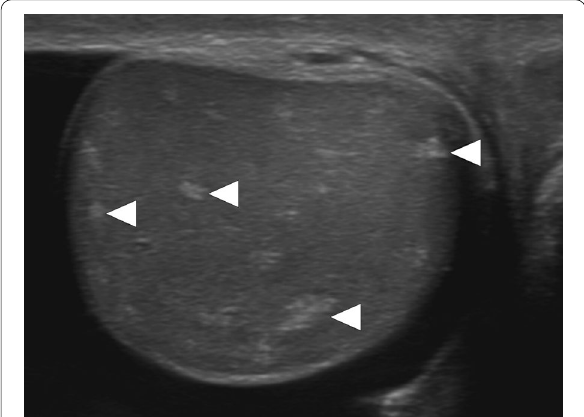
Fig. 13 Testicular IgG4-related disease (IgG4-RD). A 35-year-old male with known systemic IgG4-RD presenting with new onset of blunt testicular pain and bilaterally enlarged testes. Ultrasound image demonstrates multiple irregular shaped hyperechoic lesions (arrowheads) scattered within both testes. As the process was bilateral and the patient had known IgG4-RD, a non-operative approach was elected. Intense medical treatment provided immediate relief and follow-up US study 6 months after the first US revealed stable